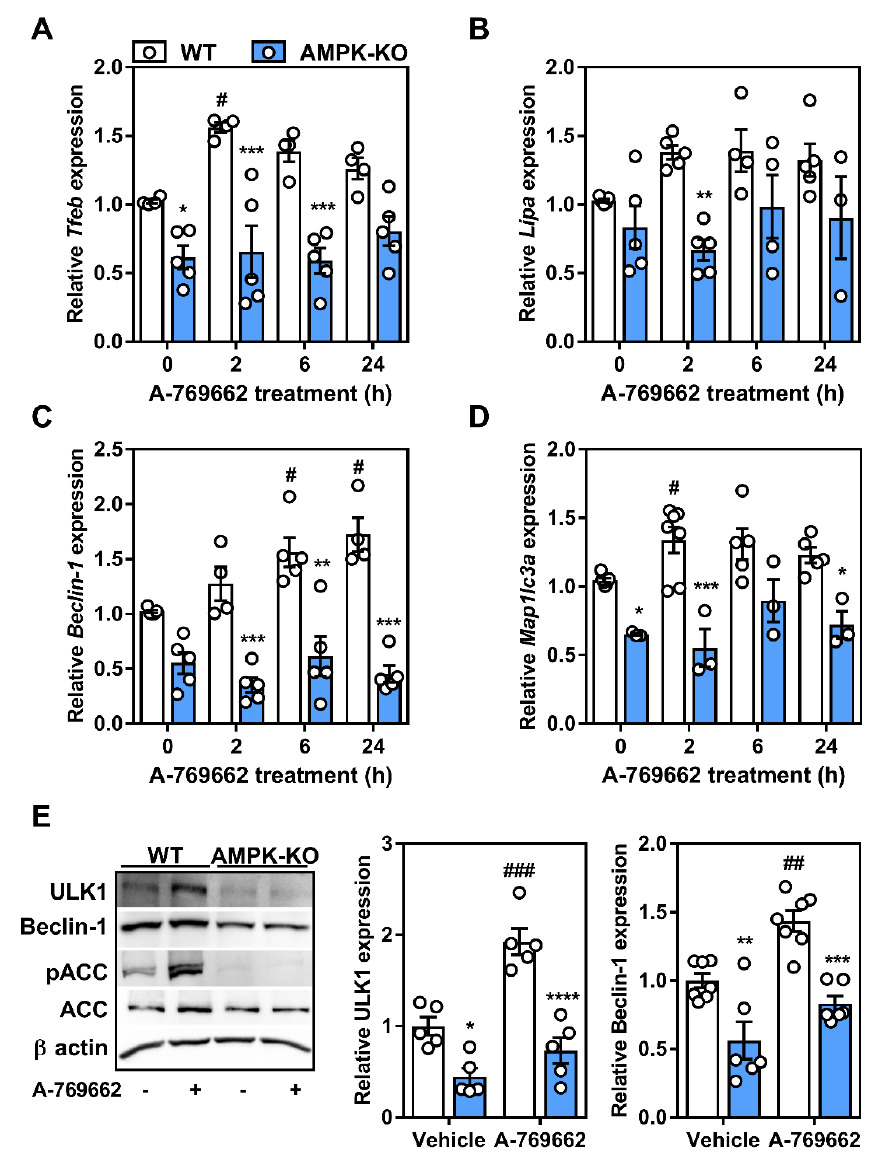
Figure 6. Macrophage AMPK activation leads to the upregulation of autophagy-related genes. Relative transcript expression in response to AMPK activation (A-769662 100 µ M) over time for ( A ) Transcription factor EB (TFEB, encoded by Tfeb ), ( B ) lysosomal acid lipase ( Lipa ), ( C ) Beclin-1 ( Beclin-1 ), and ( D ) LC3 ( Map1lc3a ). Transcript expression was normalized to the average expression of β -actin and Tbp. ( E ) Protein expression of ULK1 and Beclin-1 were determined following treatment ± A-769662 (100 µ M) for 24 h. ULK1 (150 kDa), Beclin-1 (52 kDa), pACC / ACC (260 kDa), and β actin (37 kDa). Data represent the mean ± SEM, where *, **, ***, and **** represent p < 0.05, p < 0.01, p < 0.001, and p < 0.0001 between genotypes, respectively, and where # , ## , and ### represents p < 0.05, p < 0.01, and p < 0.001 between treatments, as calculated by a 2way ANOVA.